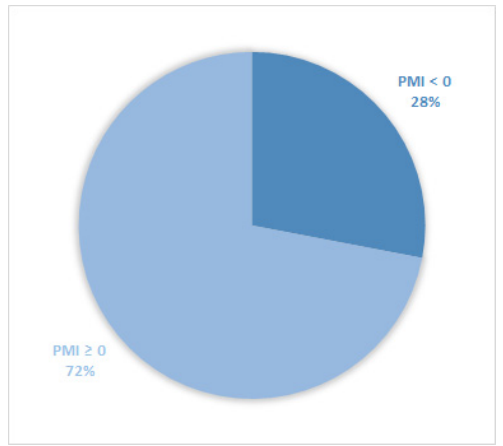
Figure 3. Pie chart displaying the percentage of patients with PMI < 0 and PMI ≥ 0. Only patients undergoing palliative radiotherapy were included (791).